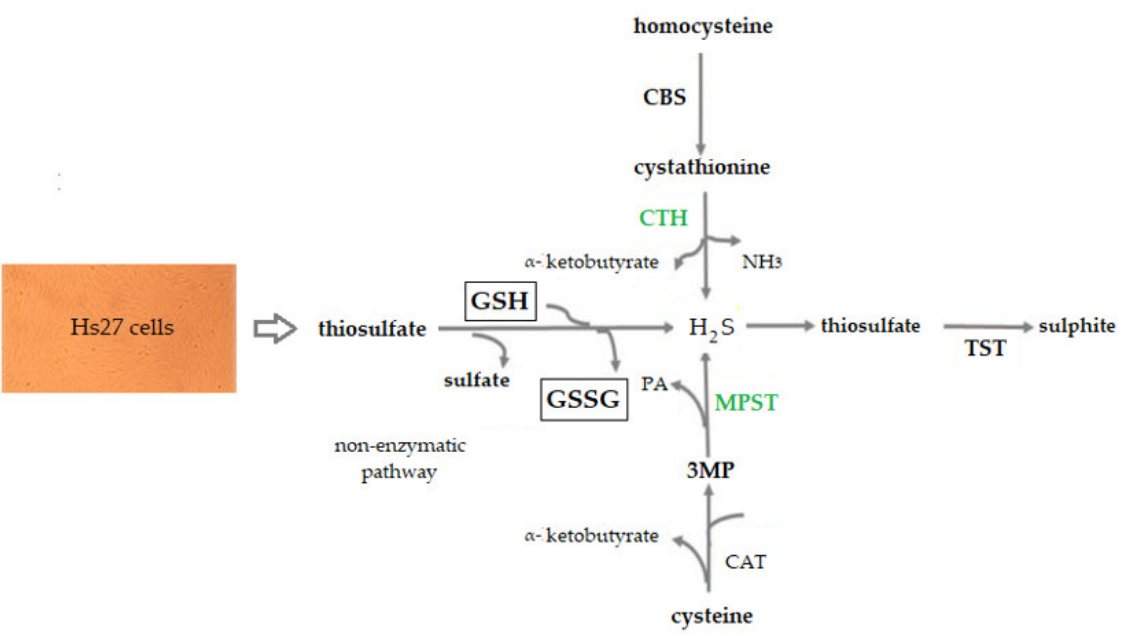
Figure 1. H 2 S metabolism in Hs27 cell lines. CBS—cystathionine β -lyase, CTH— γ -cystathionase, GSH—glutathione reduced form, GSSG—glutathione oxidized form, MPST—3-mercaptopyruvate sulfurtransferase, TST—rhodanese, CAT—cysteine aminotransferase, 3MP—3-mercaptopyruvate,